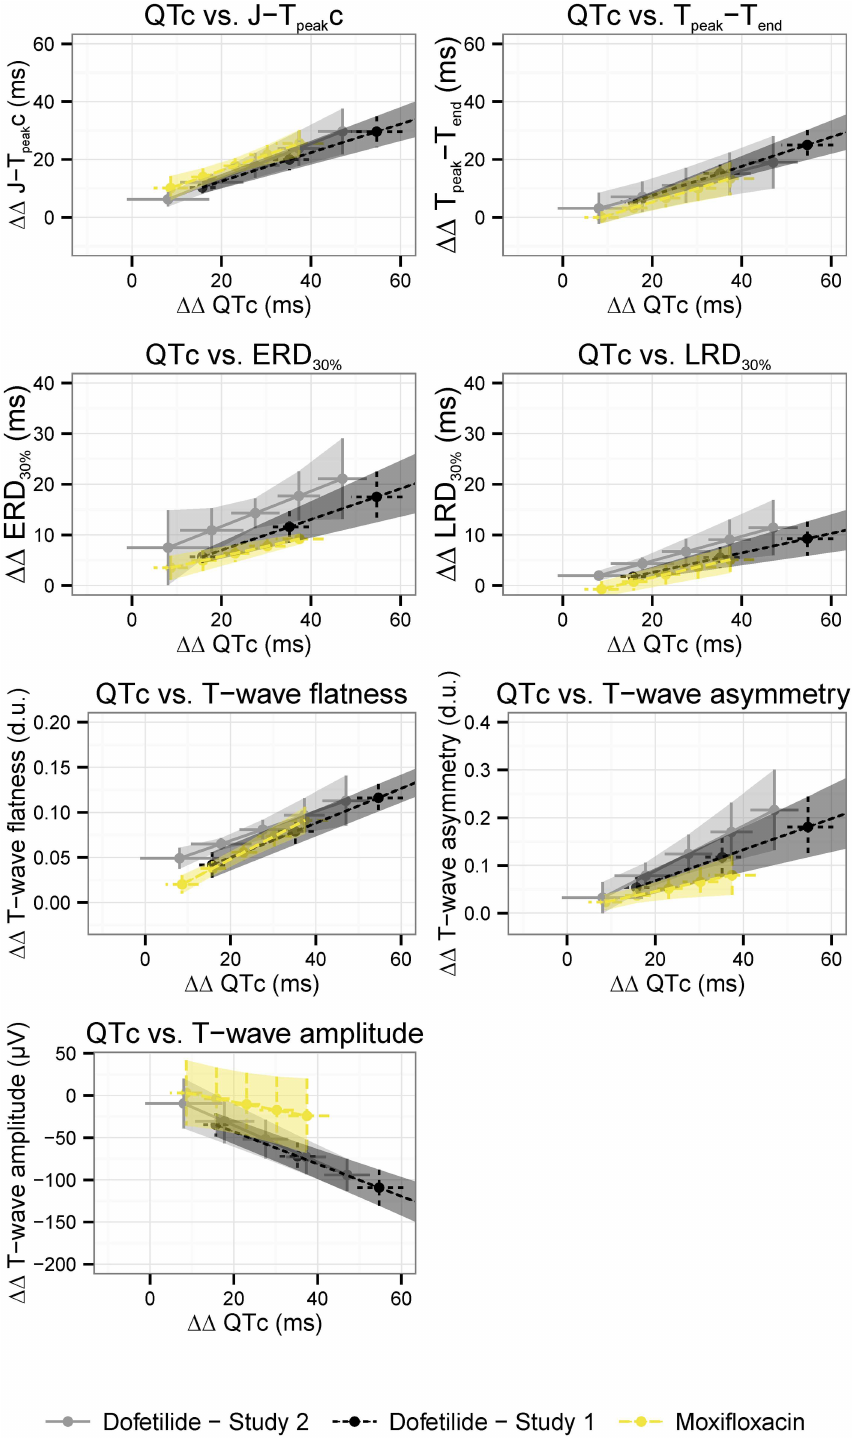
Fig 1. ECG “signature” of selective hERG potassium channel block. The ECG “signature” of selective hERG potassium channel block is shown as the relationship between predicted drug-induced placebo- corrected changes from baselinein QTc and (a) J-T peak c, (b) Tpeak-Tend, (c) 30% of early repolarization duration, (d) 30% of late repolarization duration, (e) T-wave flatness, (f) T-wave asymmetry and (g) T-wave amplitude. Average predictions (dots) and 95% confidence intervals (horizontaland vertical lines) are from